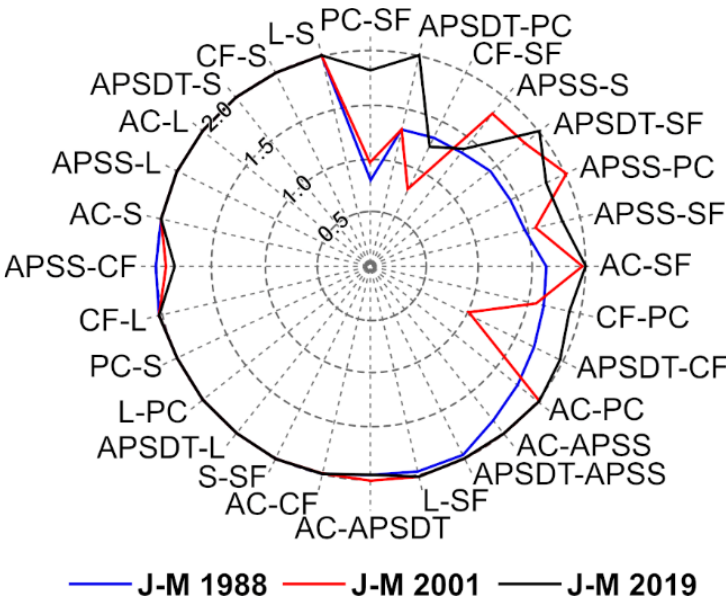
Figure 5. Jeffries–Matusita values for each land use type.